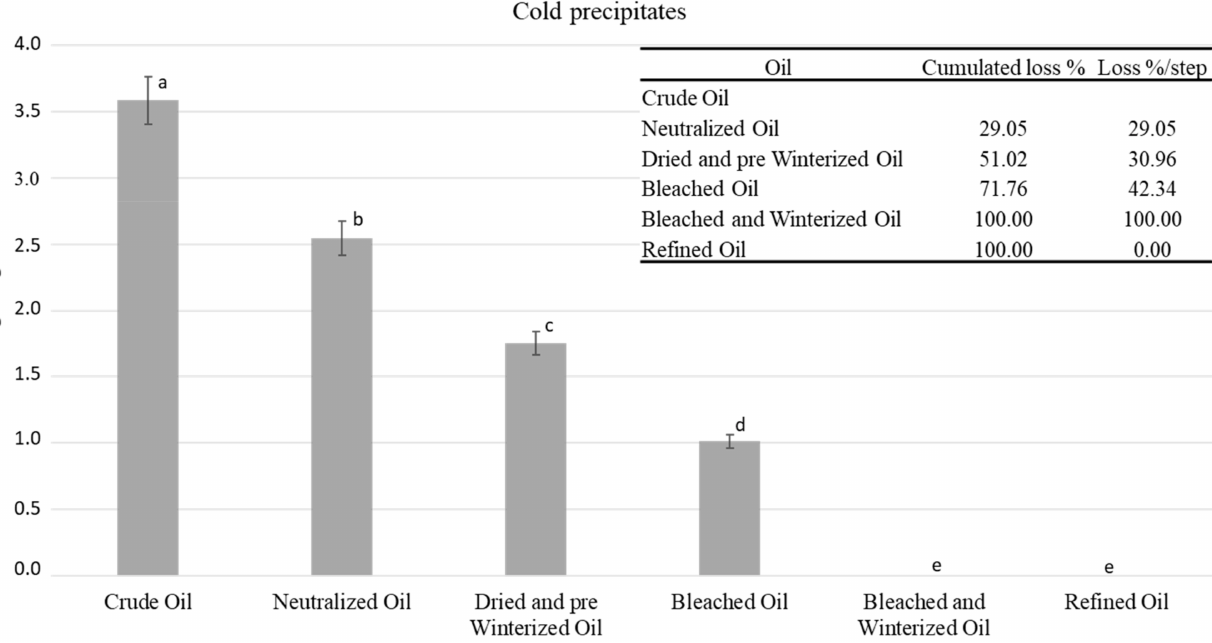
Figure 1. Evolution of the content of cold precipitates during the refining process, a–e different letters mean significant differences between steps p < 0.05 (Tukey’s